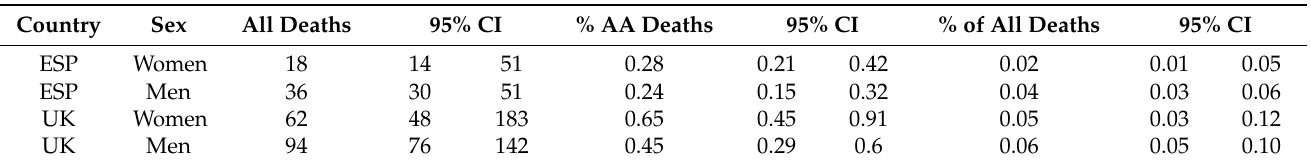
Table 3. Public health impact of introducing beer and wine with less than 0.5% alcoholic strength in the UK (6 years) and Spain (5 years)—cumulative